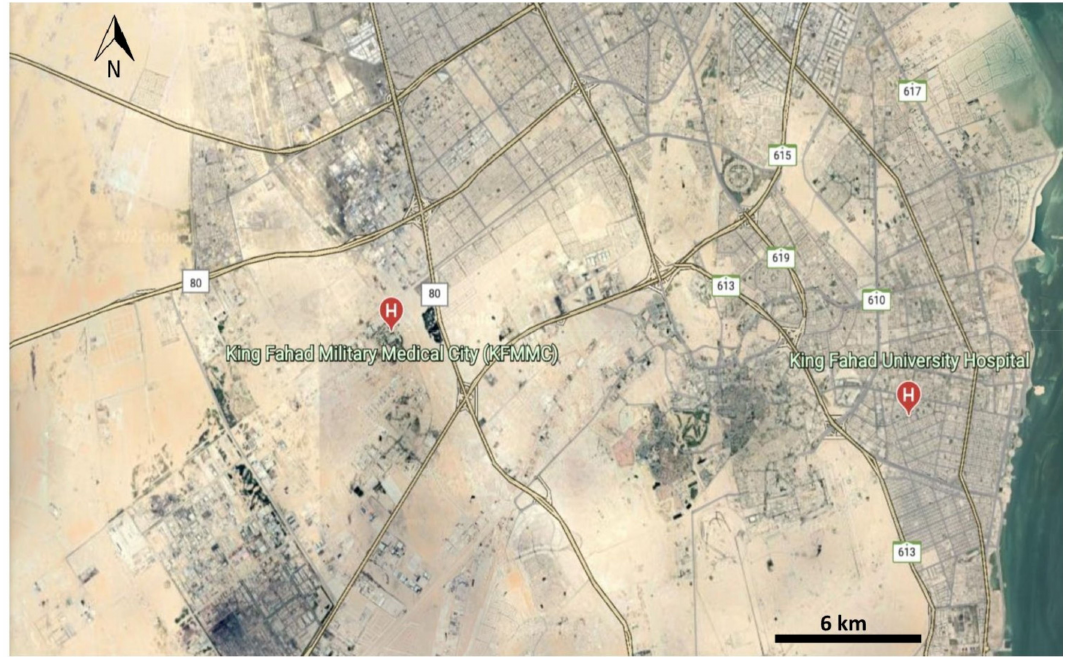
Figure 1. King Fahad University Hospital at Khobar City (26.29973, 50.1896) and King Fahad Military Medical Complex at Dammam City (26.32212, 50.02061); geographic coordinates of the origin shown on the images is (26 ◦ 18 (cid:48) 39” N 50 ◦ 06 (cid:48) 18” E); screenshot Google Earth version Imagery date 18 June